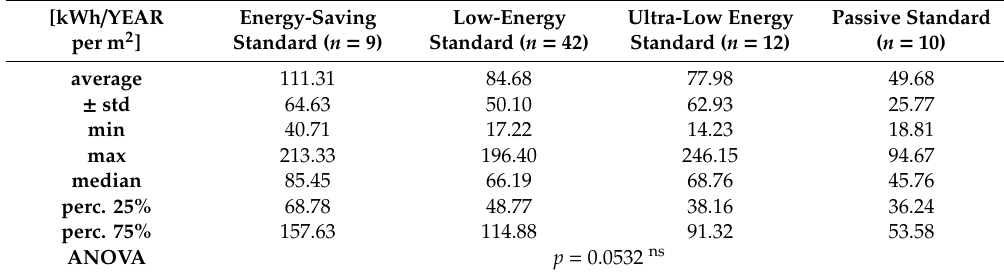
Table 2. Annual energy demand for heating categorized according to energy standards calculated per m 2 of useful floor area of the analyzed wood constructions regardless of the construction system.